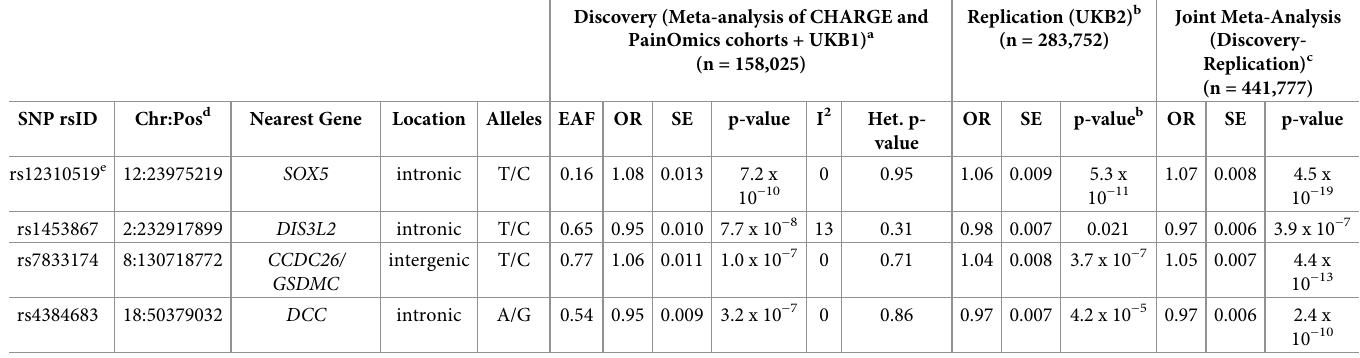
Table 2. Association results for chronic back pain: Meta-analysis (discovery), replication, and joint meta-analysis (cid:3) .